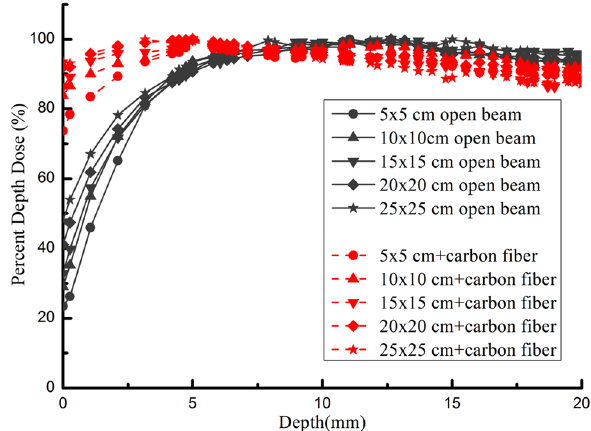
Figure 4. The comparison of the measured percent depth doses (PDDs) curves between open beam irradiation and those with carbon fiber couch involved for different field sizes.